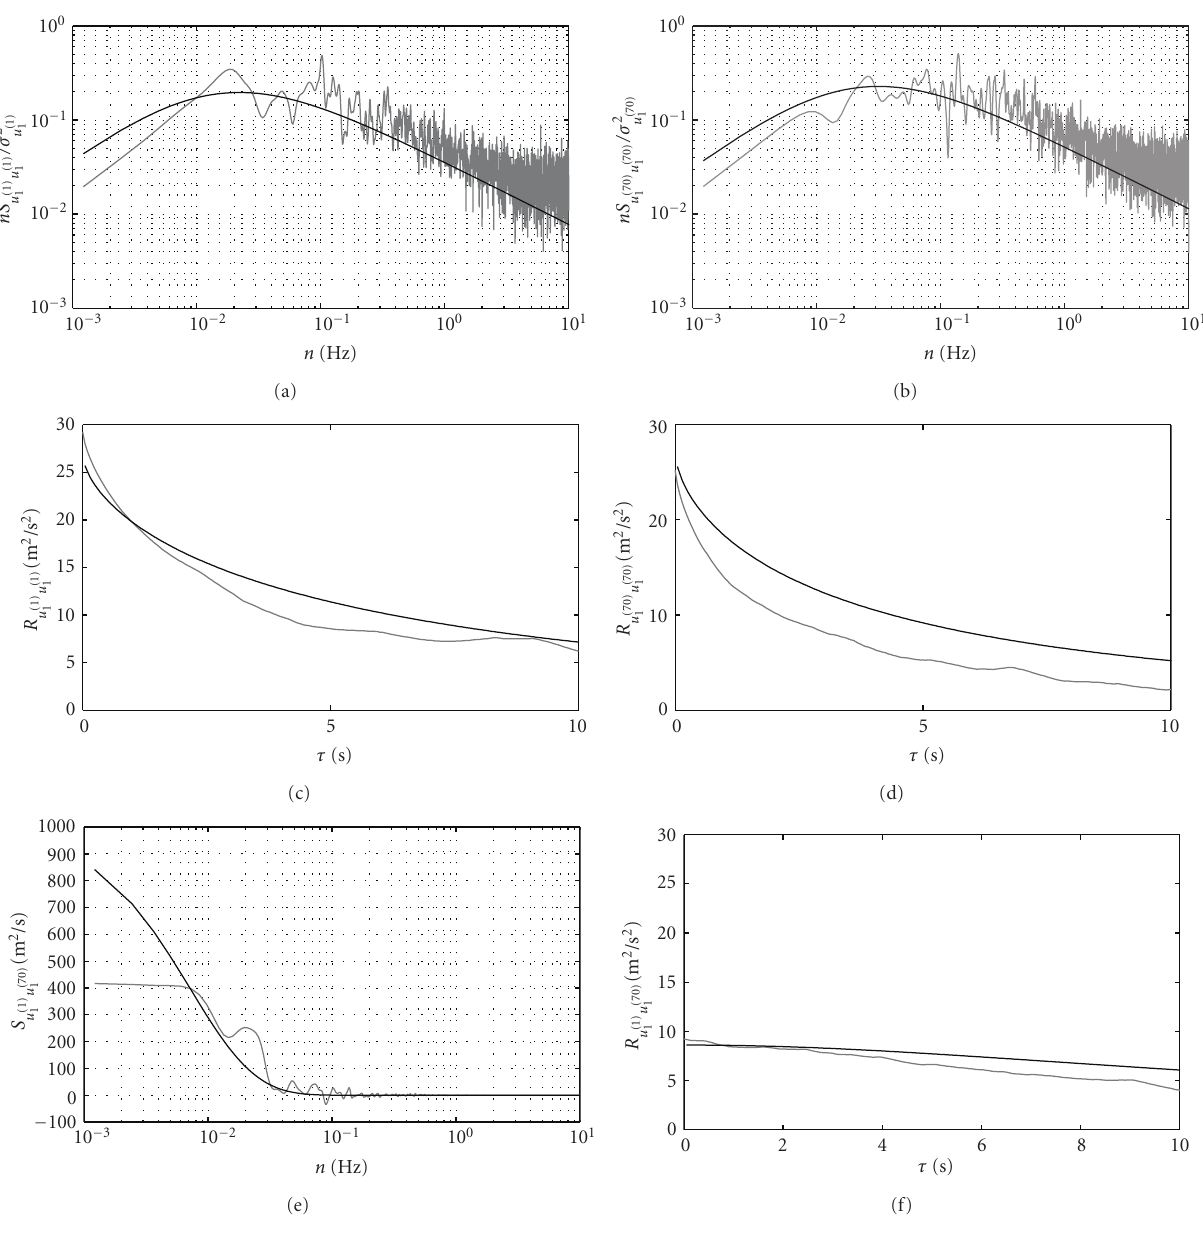
Figure 13: Example 2 using AR method (black lines denote target functions, gray lines denote numeric approximations): auto-spectra of along-wind velocities at points 1 and 70 (a), (b); corresponding autocorrelation functions (c), (d); cross-spectrum between along-wind velocities at points 1 and 70 (e); corresponding cross-correlation function